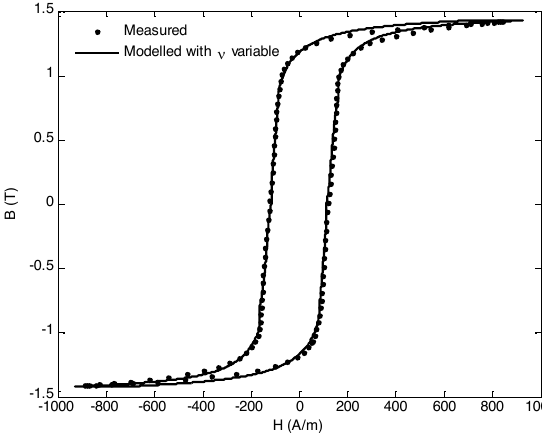
FIGURE 4. Modelled and measured hysteresis loops at 200 Hz